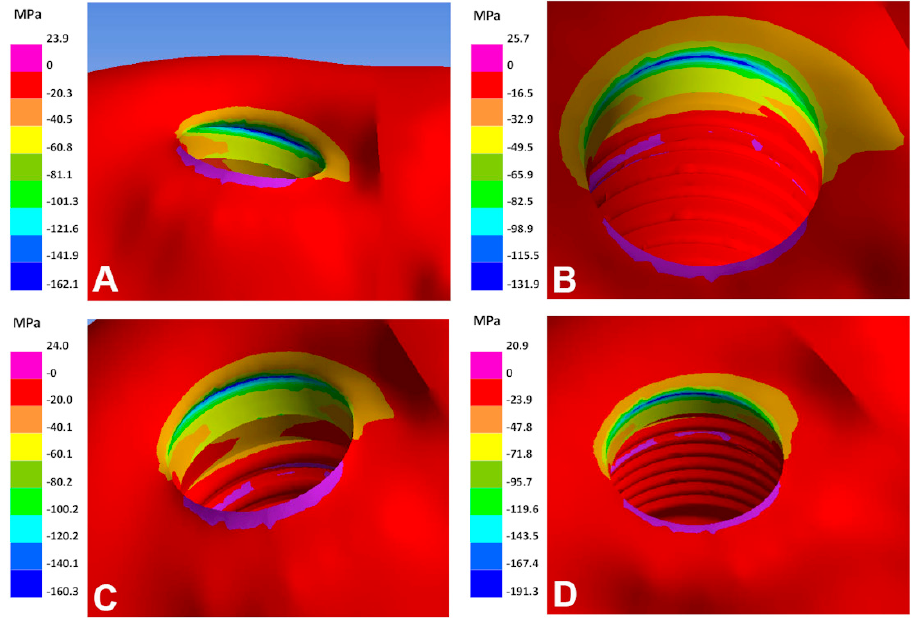
Figure 3. Minimum principal stresses in the bone of different implant alloys. ( A ) Ti–6Al–4V; ( B ) Ti–